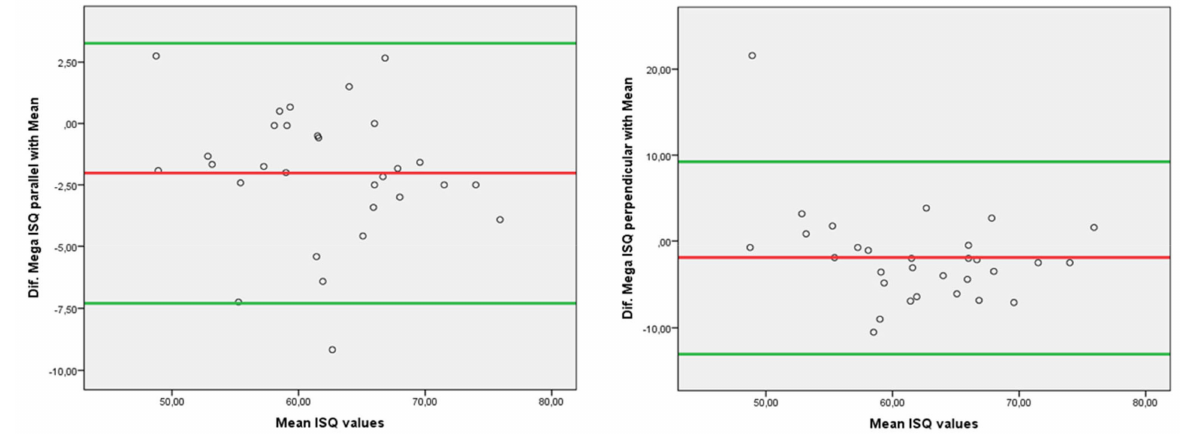
Figure 2. Bland–Altman plot with the difference between the measurements of each device and technique and the mean ISQ values.